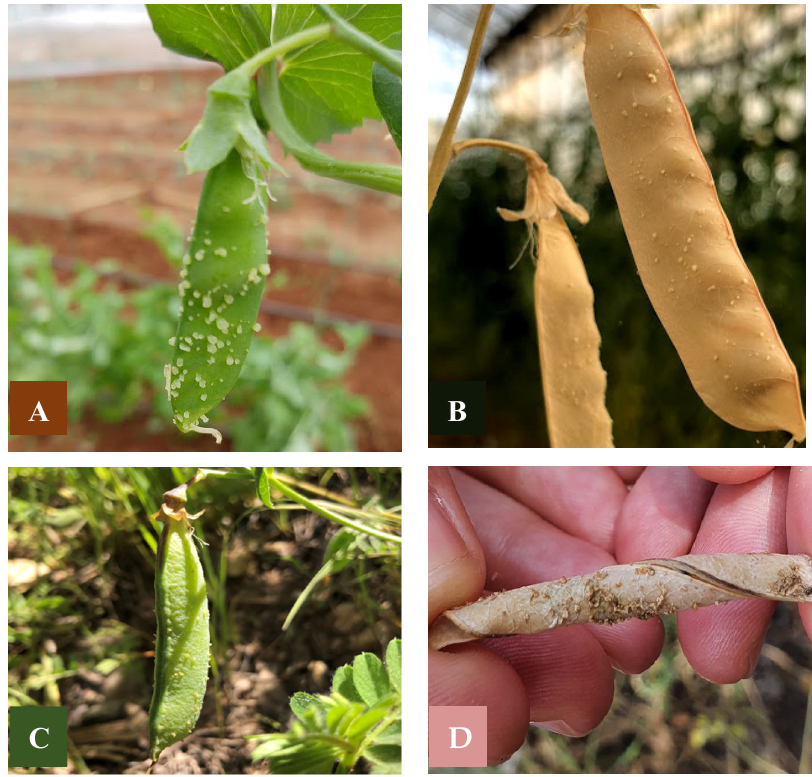
Figure 4. Neoplasm on a young pod ( A ) and two mature pods ( B ) of a progeny derived from inter-subspecific crosses between P. sativum subsp. sativum (ACP 13) and P. sativum subsp. elatius (AWP 442) in the F 2 population under glasshouse conditions in 2019. Neoplasm on a young ( C ) and mature pod ( D ) of a tall wild pea ( P. sativum subsp. elatius ) in its natural habitat in the Taurus Mountains, Antalya, Turkey in 2020.